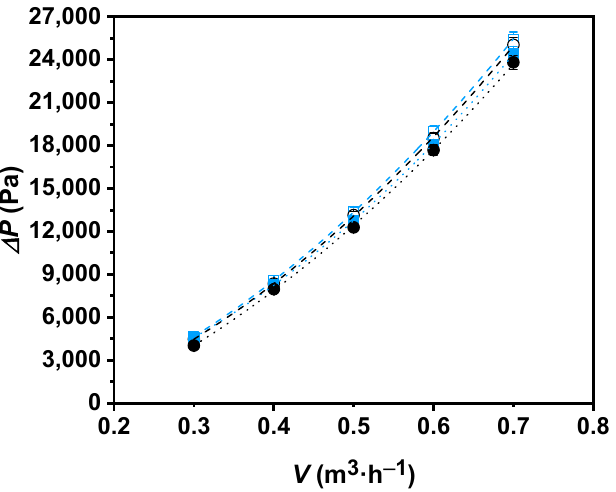
Figure 7. Experimental pressure drops, Δ P , for water (black) and 0.50 wt% P-GnP/W nanofluid (blue) as a function of volume flow rate, V , at 308.15 K ( ○ , ☐ ) and 318.15 K ( ● , ■ ). Error bars indicate expanded uncertainty ( k = 2).